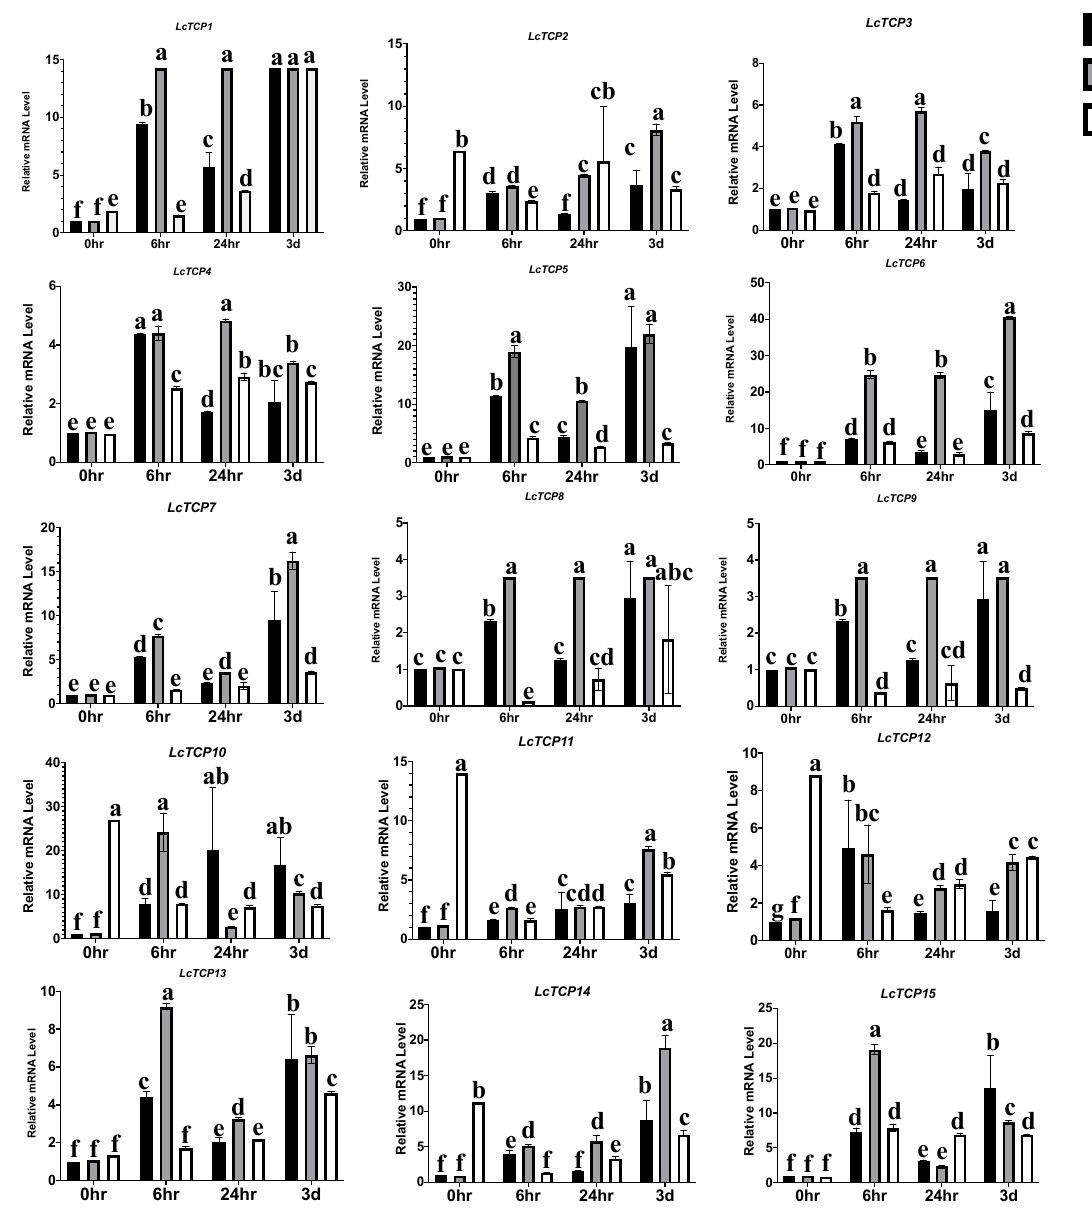
Figure 11. Confirmation of the expression patterns cold-, heat- and drought-responsive LcTCPs using qPCR. The expression patterns of LcTCP under cold, heat, and drought stress. The values shown are the means +/ − SD of the three replicates. Letters (a–f) on top of the error bars show the significant differences within time treatments. Previous research has established the C-repeat Binding Factor (CBF) transcription factors as the main downstream regulators of the abiotic stresses in the abscisic (ABA) - independent pathway [40,41]. Guan et al. [42] identified the CBF gene family in L. chinense and analyzed their expression patterns using the qRT-PCR and transcriptome